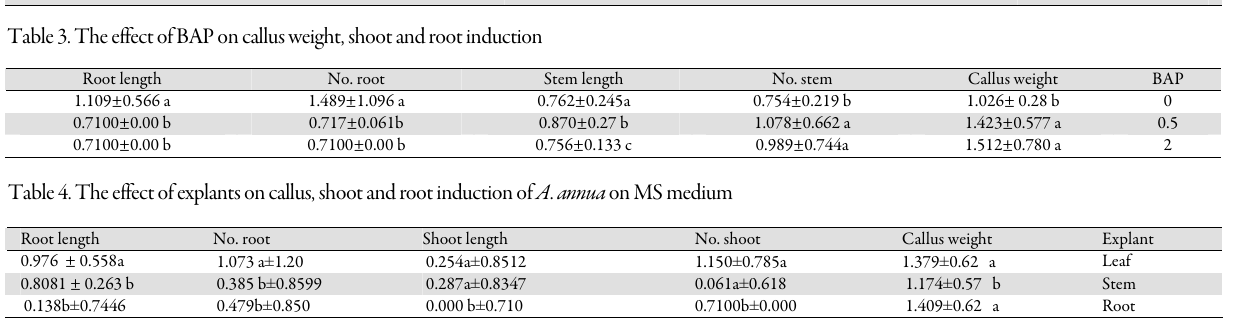
Table 5. The interaction between carbon source and BAP on callus, shoot and root induction of A . annua on MS medium Root length